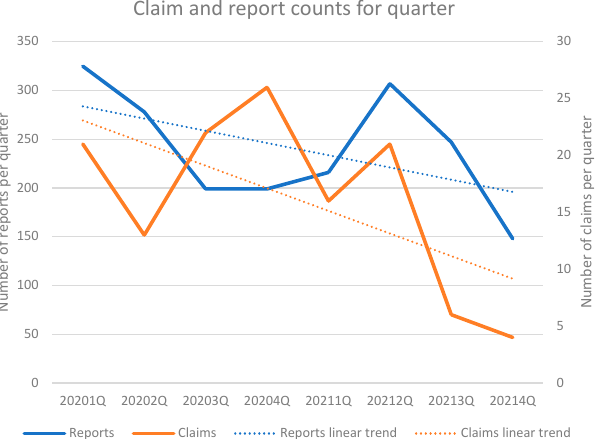
Int. J. Environ. Res. Public Health 2022 , 19 , x FOR PEER REVIEW Figure 3. Claim and report counts (years 2020–2021) for quarter. Figure 3. Claim and report counts (years 2020–2021) for quarter.